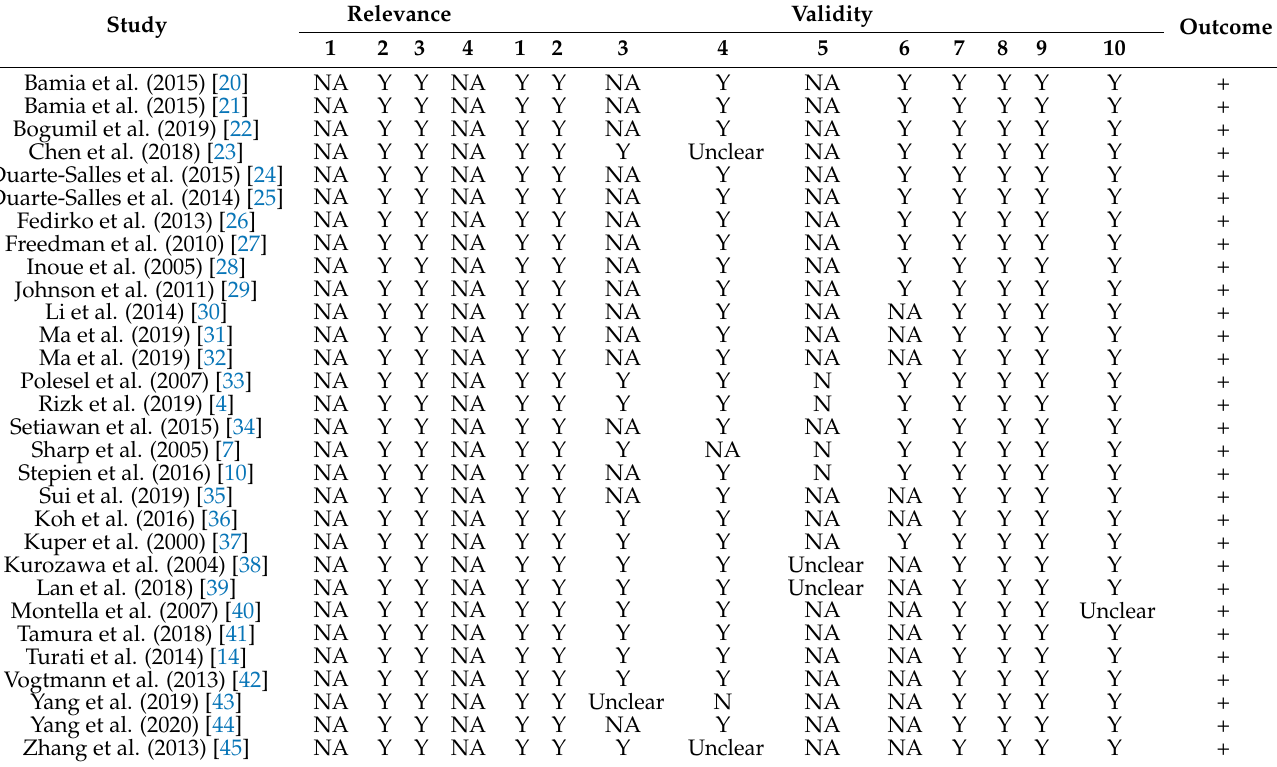
Table 4. Critical appraisal of the 30 studies with the use of the Quality Criteria Checklist.